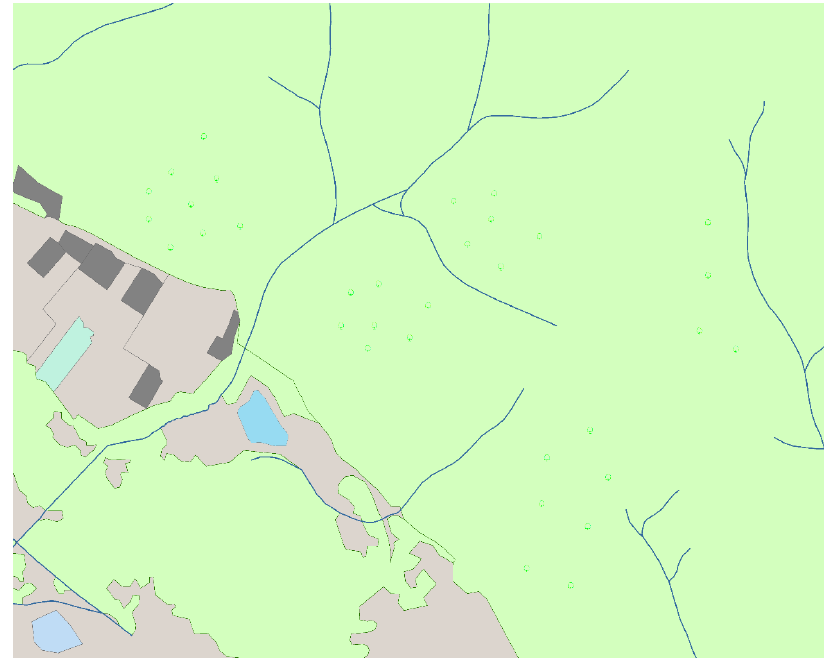
Figure 3. Point features (trees) represented with minimum monochrome dimensions. Points are shown in green on a light green background. The decrease in perception is significant.